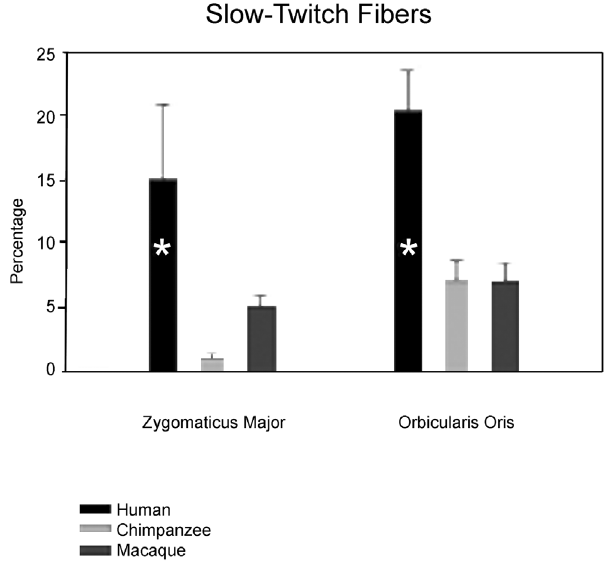
Figure 2. Percentages of fast-twitch myosin fibers in facial muscles. Results of one-way ANOVA and post-hoc Least Squares Difference testing in the zygomaticus major muscle indicate that chimpanzees had the highest percentage of fast-twitch myosin fibers and humans had the lowest (chimpanzee . macaque . human) at the p , 0.05 level of statistical significance. In the orbicularis oris muscle, humans had the lowest percentage of fast-twitch fibers (chimpan- zee=macaque . human) at the p , 0.05 level of statistical significance. The presence of a ‘‘*’’ indicates that the group mean percentage was significantly different from the other groups. Means with SEM are shown.